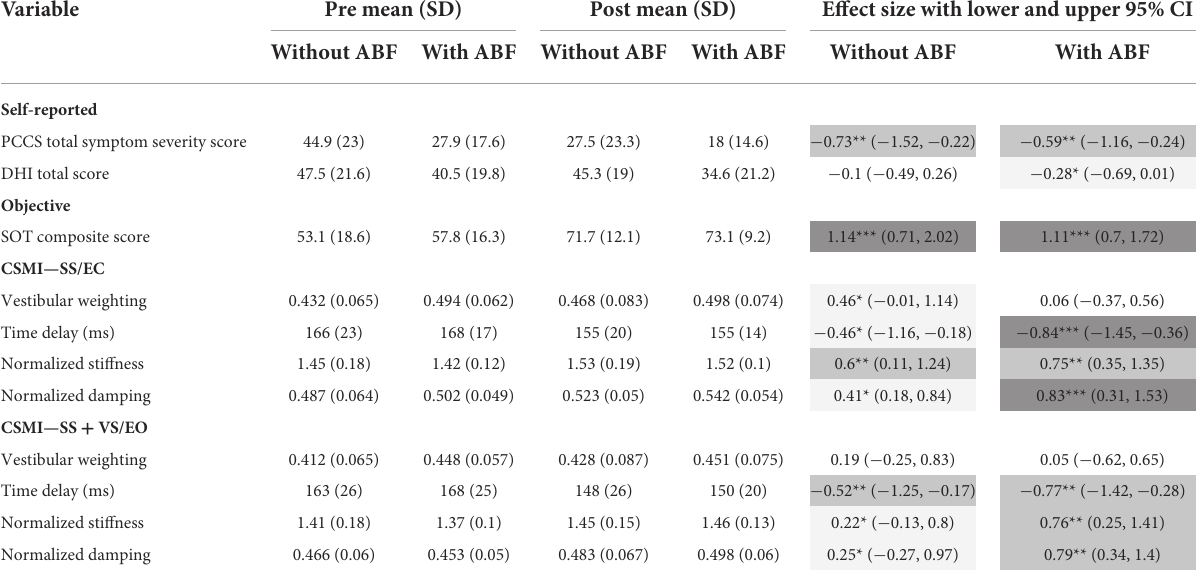
TABLE 4 Means, standard deviations (SD), and effects sizes with lower and upper 95% confidence limits (Cl) for rehabilitation without and with audiobiofeedback (ABF) groups pre- and post-rehabilitation on self-reported (Post-Concussion Symptom Scale—PCSS; Dizziness